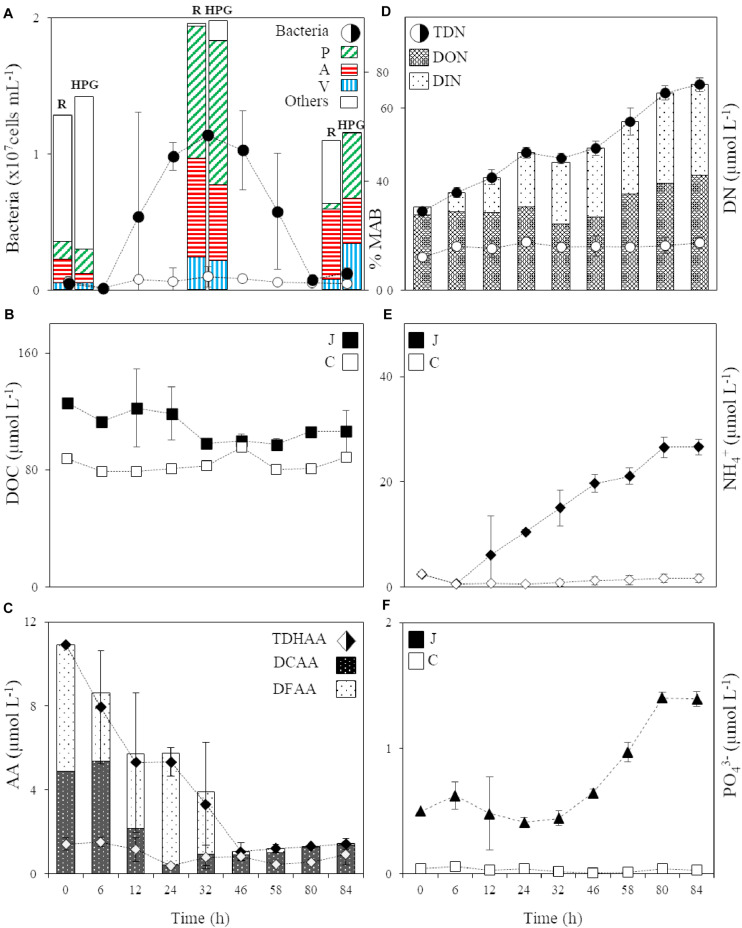
(A) Abundance of the bacterial community in the jelly-OM (filled circle) and control (circle) treatment and the percentage of respiring (R) and HPG incorporating (HPG) bacteria in the two jellyfish degradation experiments (average of both experiments ± SD), together with the percentage of respiring and HPG incorporating Pseudoalteromonas (P), Alteromonas (A), and Vibrio (V) and other bacterial populations (Others) within the active microbial community at T0, in the late exponential (at 32 h, Experiment I) and decay phase of bacterial growth (at 84 h, Experiment II), MAB stands for Metabolically Active Bacteria; (B) DOC in the jelly-OM (filled square) and control (square) treatments; (C) TDHAA, DCAA and DFAA in the jelly-OM (filled diamond) and TDHAA in control (diamond) treatments; (D) TDN, DON and DIN in the jelly-OM (filled circle) and TDN in control (circle) treatments; (E) NH4+ in the jelly-OM (filled diamond) and control (diamond) treatments; (F) PO43– in the jelly-OM (filled triangle) and control (triangle) treatments in the two jellyfish degradation experiments (average of both experiments ± SD). In panels (B, E, F) J stands for jelly-OM treatment and C stands for control treatment without jelly-OM amendment.